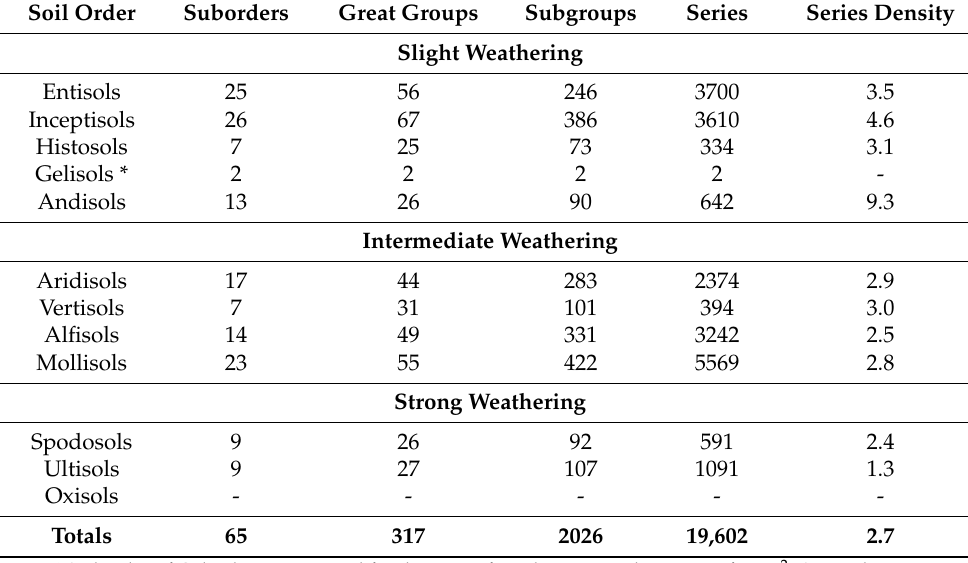
Table 7. Soil diversity (pedodiversity) is expressed as the number of soil classes (taxonomic pedodi- versity) within soil orders in the contiguous United States (U.S.) based on Soil Survey Geographic (SSURGO) Database (2020)